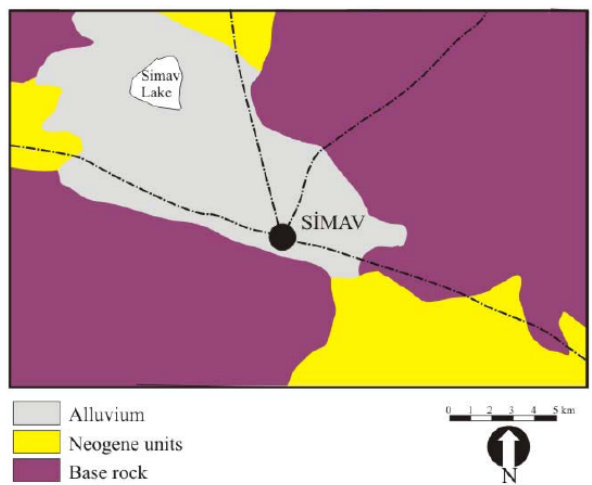
Fig. 3. Simplified geological map of Simav and its vicinity (Inel et al., 2011).